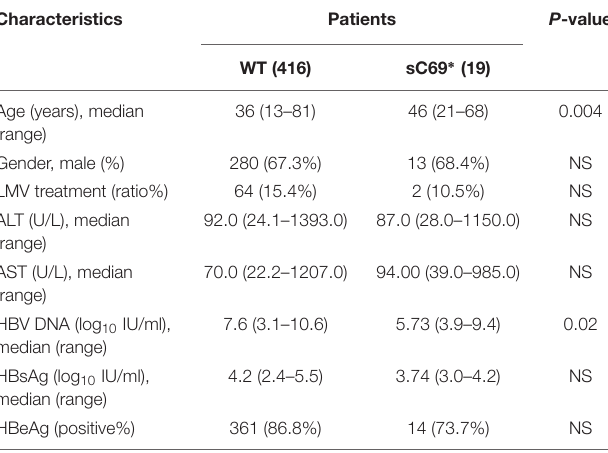
TABLE 1 | Comparison of clinical data between patients with and without sC69 ∗ substitution. Characteristics